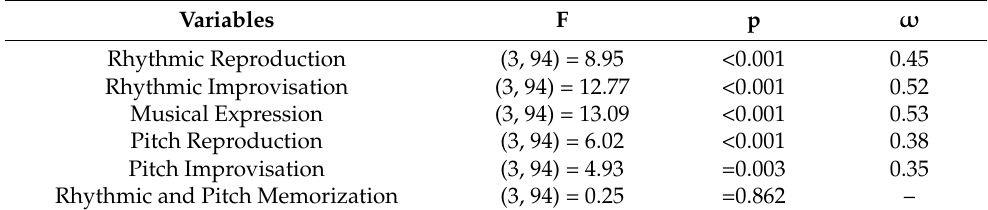
Table 3. ANOVA results of the six different variables of the Musical Performance Assessment Scale.